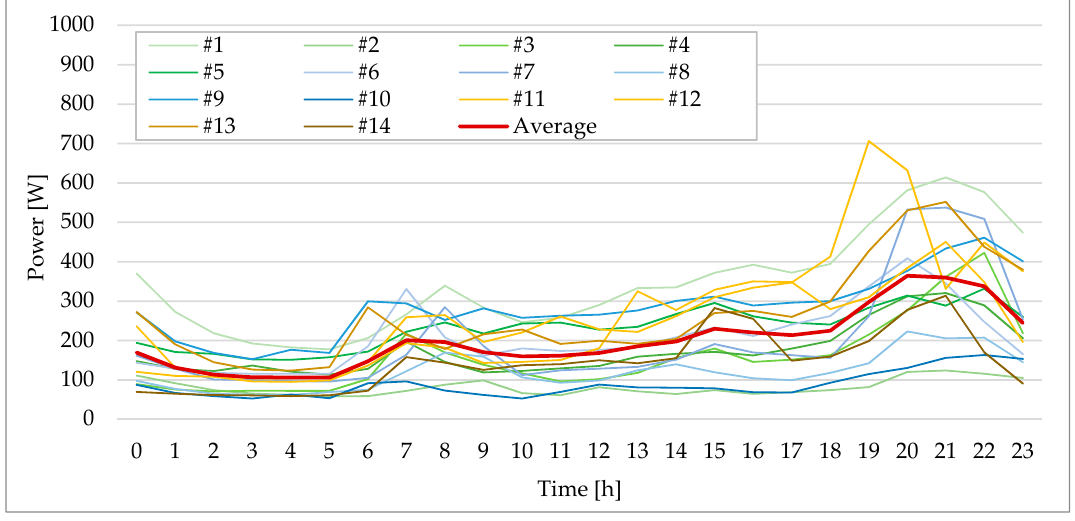
Figure 6. Archetypes average daily profiles over the weekdays.